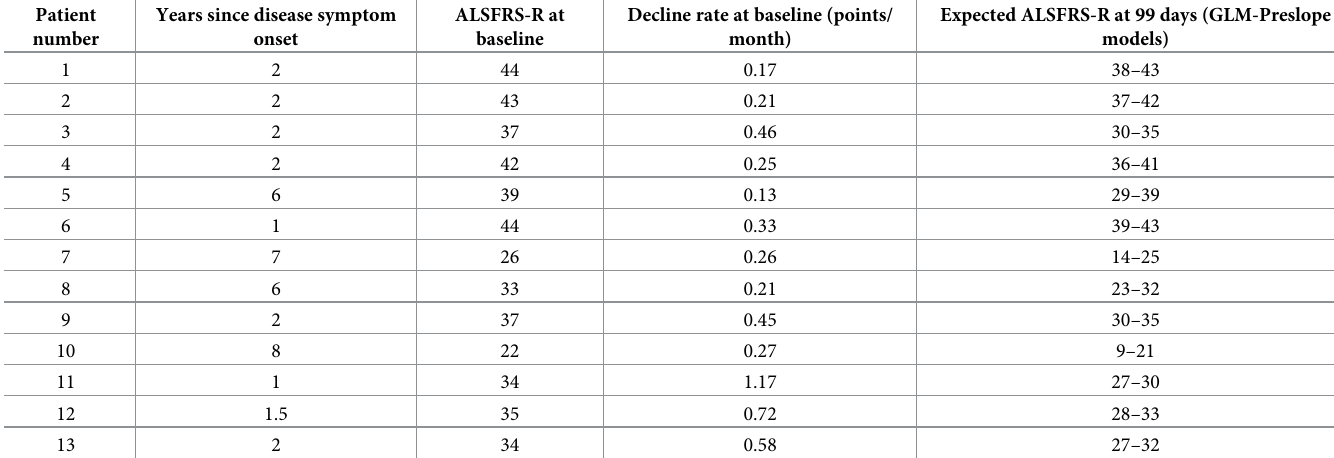
Table 4. Patient characteristics.